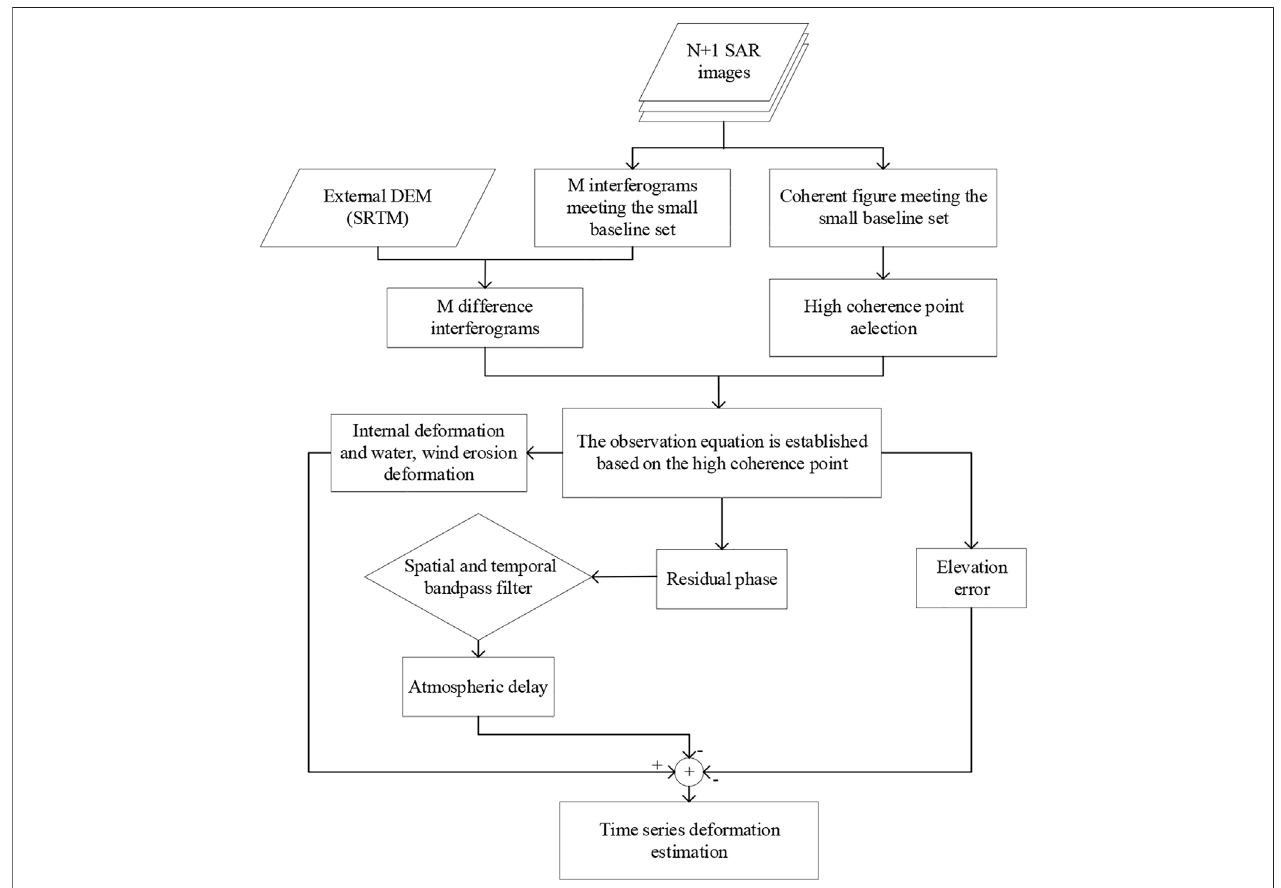
FIGURE 2 | Flow chart of the improved small baseline subset interferometric synthetic aperture radar (SBAS-InSAR) algorithm.